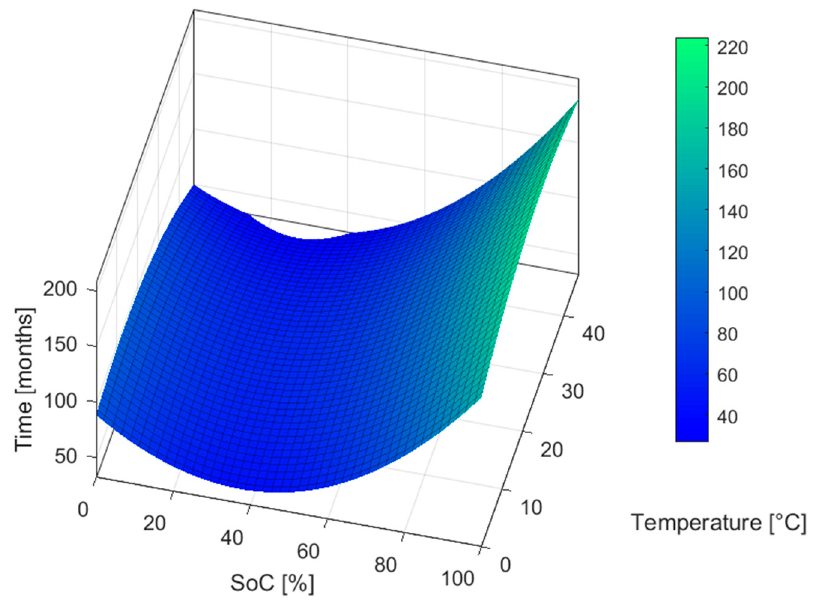
Figure 6. The expected time, expressed in months, for the LiC to increase the IR to 200% due to calendar aging.